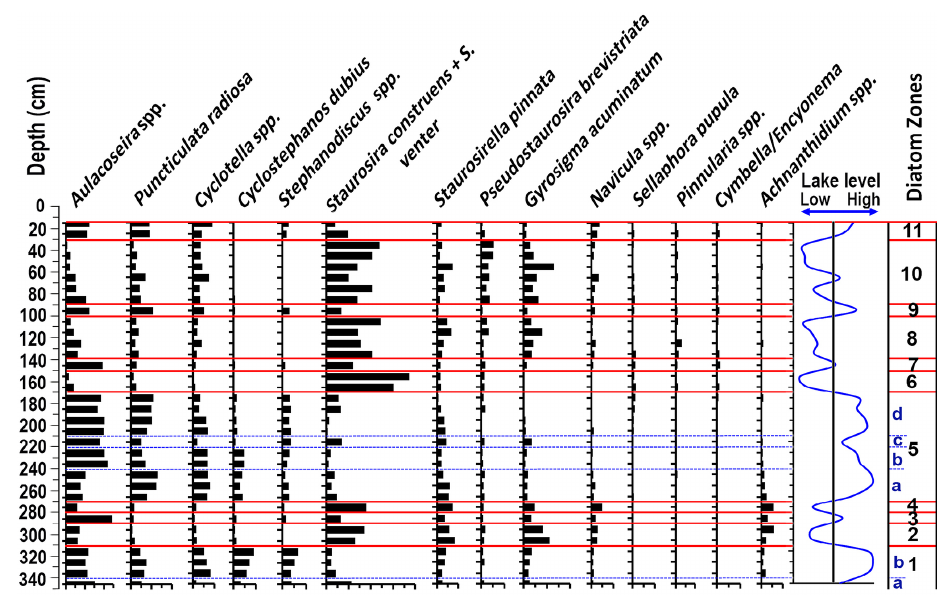
Figure 8. Diatom stratigraphy of the core M1, showing diatom zones and lake phases and relative water level changes estimated based on the relation between planktonic and benthonic diatom taxa (interpretation and drawing: Abdelfattah Zalat).